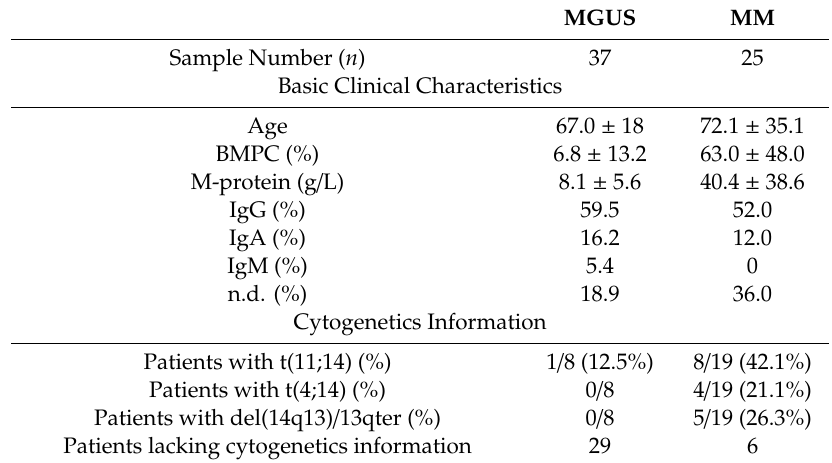
BMPC indicates the degree of bone marrow plasma cell infiltration; M-protein indicates the serum level of myeloma protein. IgG, IgA, and IgM indicate the percentage of patients in each cohort with each of the three isotypes of immunoglobulin heavy chain as the predominant isotype; n.d. is the percentage of patients whose immunoglobulin isotype data were unavailable. Numbers represent average values along with the maximal variance in these